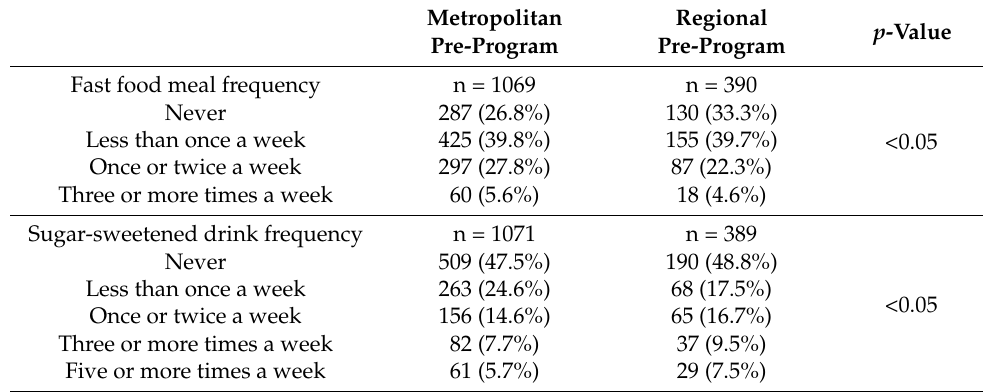
Table 3. Self-reported fast food meal and sugar-sweetened drink intake frequency at baseline.